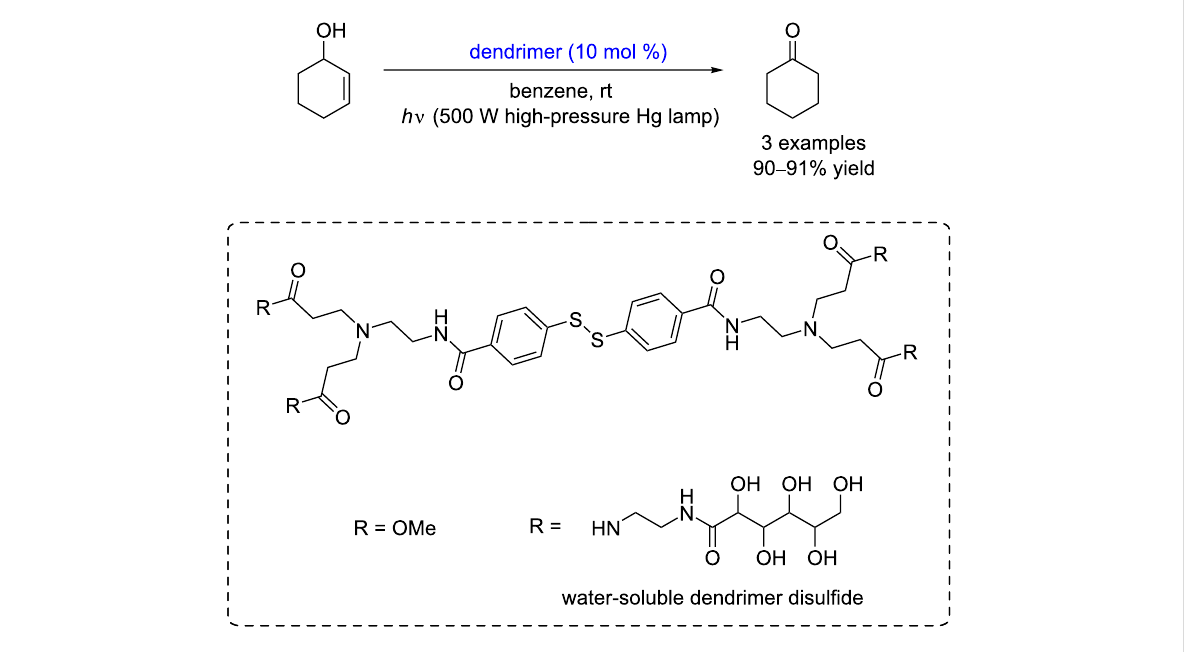
was also successful. For the photoinduced oxidation reaction